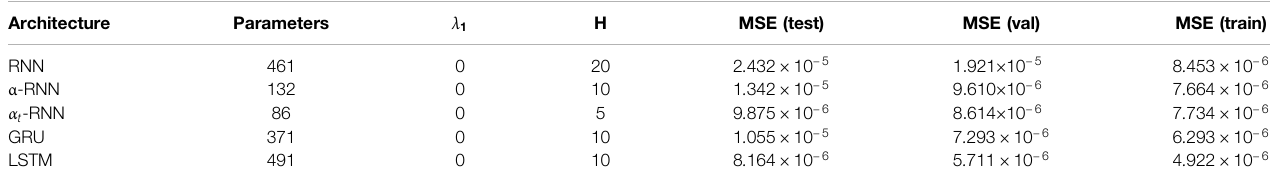
TABLE 1 | The four-step ahead Bitcoin forecasts are compared for various architectures using time series cross-validation. The half-life of the α -RNN is found to be 1.077 min ( (cid:1) α (cid:1) 0 . 4744 ).